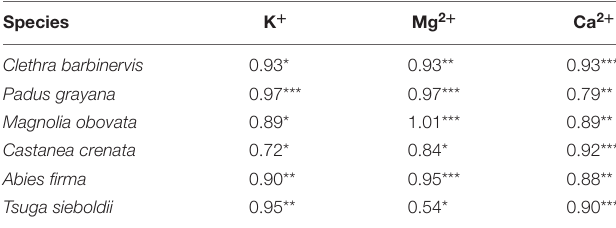
TABLE 2 | Coefficients of the relationship between time and percentage of maximum concentration over the soaking